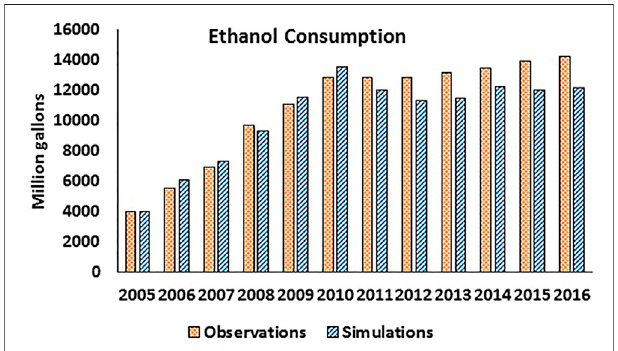
FIGURE 6 | Actual and simulated market results for ethanol consumption 2005 – 16.